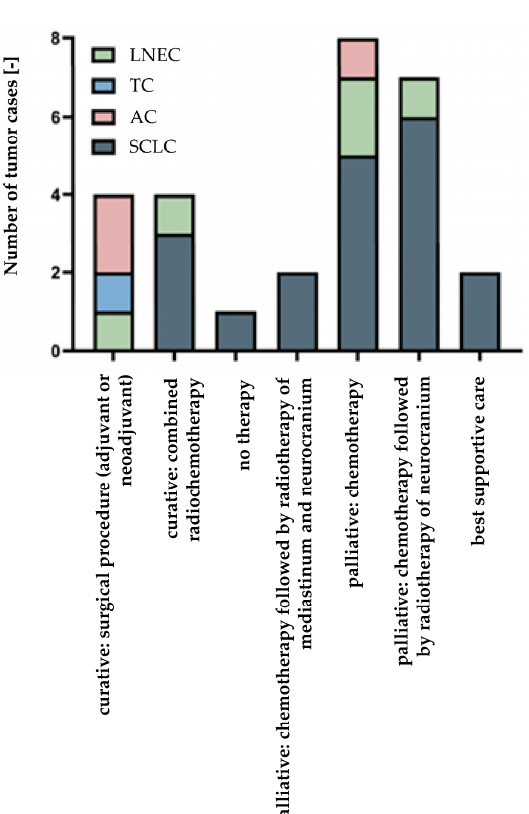
Figure 2. Therapy according to tumor entity. Large cell neuroendocrine carcinomas of the lung: LCNEC, typical carcinoids: TC, atypical carcinoids: AC, small cell lung cancers: SCLC. Three out of four carcinoids were detected relatively early (UICC stage II) and could curatively be treated by an adjuvant or neoadjuvant surgical approach. The fourth patient with a carcinoid received palliative chemotherapy. Two of the five patients with LCNEC could also be curatively treated, and the other three patients received palliative therapy. Within the group of patients with SCLC, three patients showed a limited disease stage at initial diagnosis with curative treatment. All other patients in this group received palliative therapy, which differed according to disease